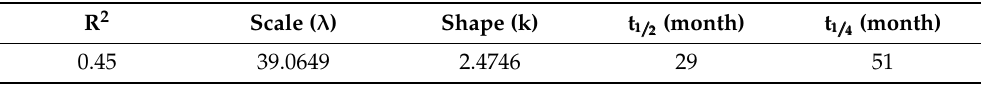
Table 5. Table of interpolation parameters used for survival estimation. The coefficient of determination and the parameters of the Weibull distribution are shown. The last two columns show an estimate of the first half-life (t ½ ) and second half-life (t ¼ ) of the population.